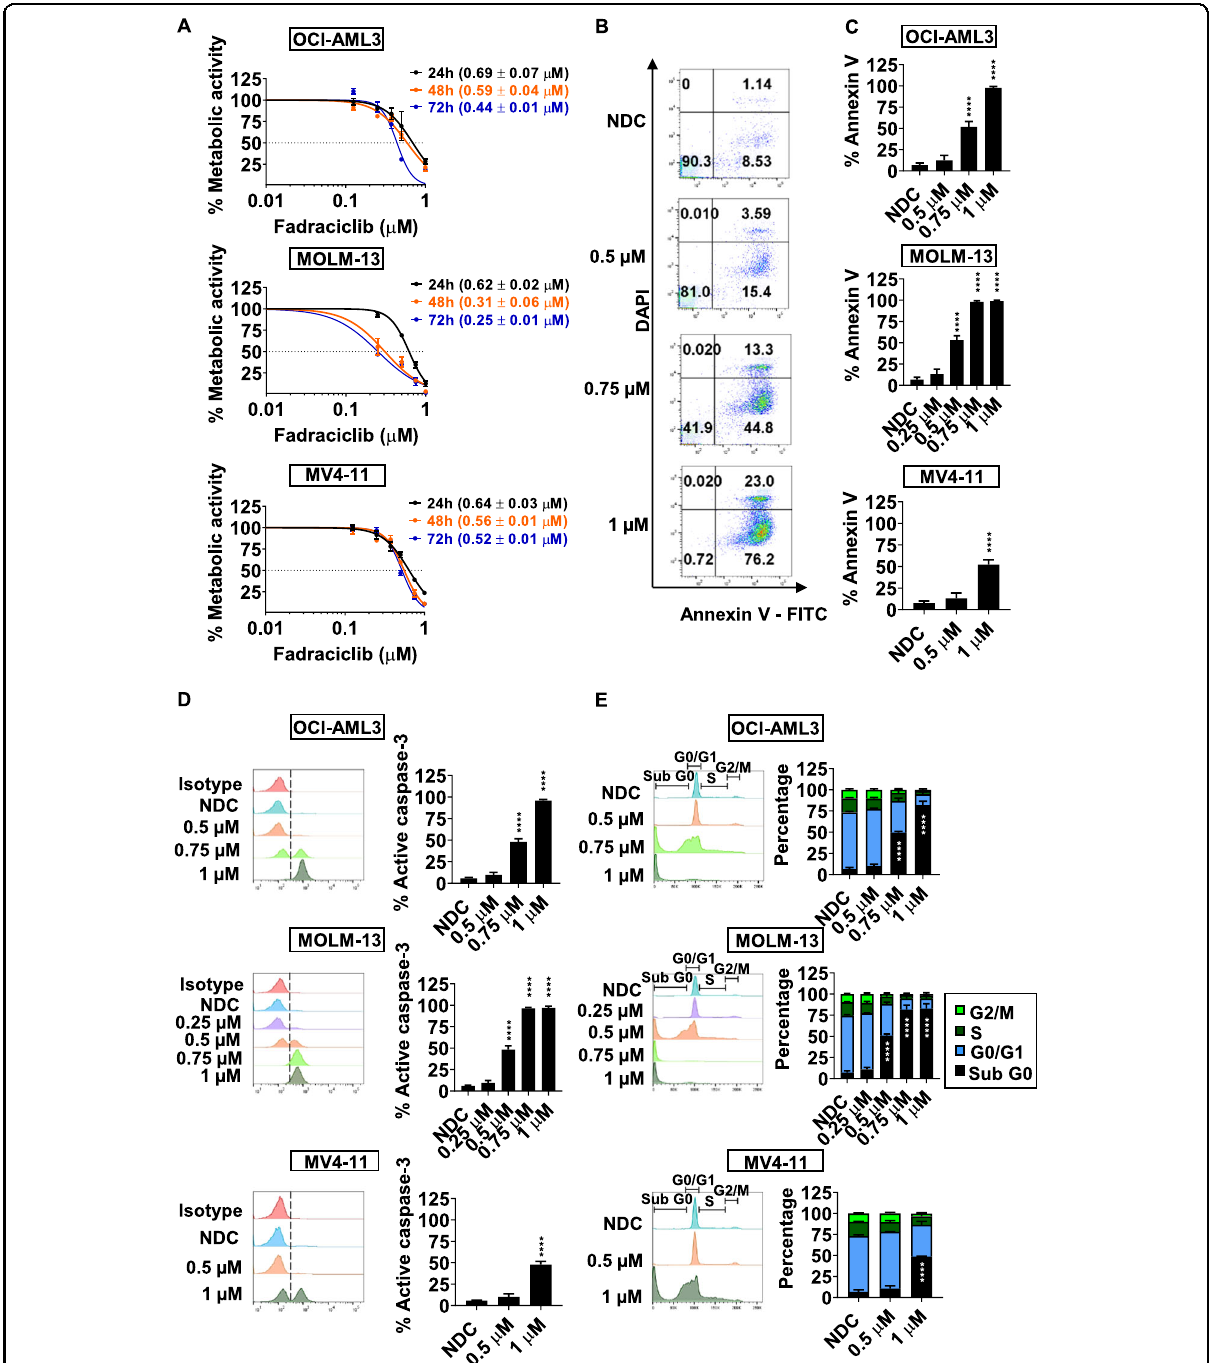
Fig. 1 Fadraciclib reduces metabolic activity and causes apoptosis of AML cell lines. A The IC50 of fadraciclib at 24, 48 and 72 h in AML cell lines using the rezasurin reduction assay. B Representative fl ow cytometry plots Annexin V/DAPI apoptosis assay for the OCI-AML3 cell line treated with fadraciclib for 72 h. C Bar charts based on fl ow cytometry data for the percentage of annexin V-positive cells in AML cell lines treated with fadraciclib for 72 h. D Representative fl ow cytometry plots and summary bar charts of the percentage of active caspase-3-positive cells in AML cell lines treated with fadraciclib for 72 h. E Representative fl ow cytometry plots and summary bar charts of cell cycle phase using PI staining of AML cell lines treated with fadraciclib for 72 h. n = 3.Graphs depict mean ± SD (**** p < 0.0001). Data were compared using